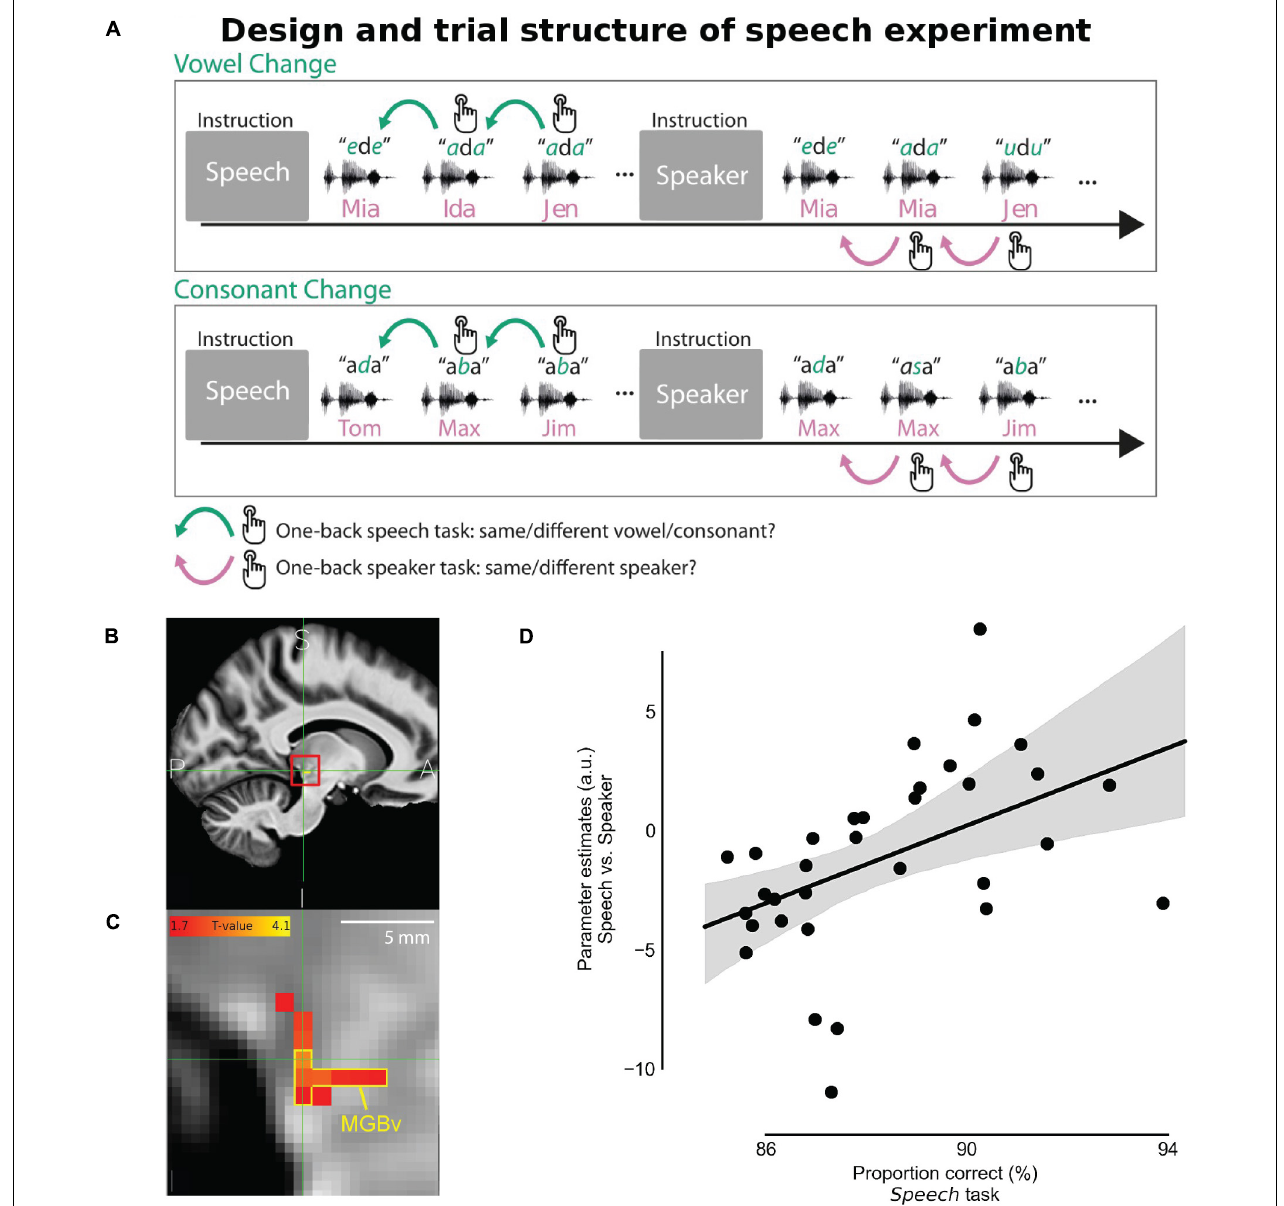
FIGURE 7 | Task-dependent modulation in MGBv for speech recognition. (A) Behavioral task design. In the speech task, participants pressed a button when a syllable changed in the sequence of vowel-consonant-vowel-syllables stimulus. In the speaker task, using exactly the same stimulus, they were instead asked to report when speaker identity changed in regardless of syllable changes. (B) The panel shows the averaged structural image by fMRI (sagittal section) across participants on the human brain atlas. The location of the left MGB was estimated and indicated with the red square. A, anterior; I, inferior; P, posterior; S, superior. (C) Zoomed view of the red square in the panel B, denoting MGBv by the yellow contour. The strength of the correlation between the speech vs. speaker task contrast and the averaged behavioral correct performance rate in the speech task was depicted with hot color coding. (D) Speech vs. Speaker tasks activation at the left MGBv coordinates correlated with the proportion of correct responses in the speech task. The better behavioral performance in the speech task corresponded to the larger difference of BOLD response between speech and speaker tasks in the left MGBv. Dots represent individual participants. The line shows the best fit with the gray area indicating 97% bootstrapped confidence interval (Adapted and modified with permission from Mihai et al., 2019; Figures 1C, 6, 7).